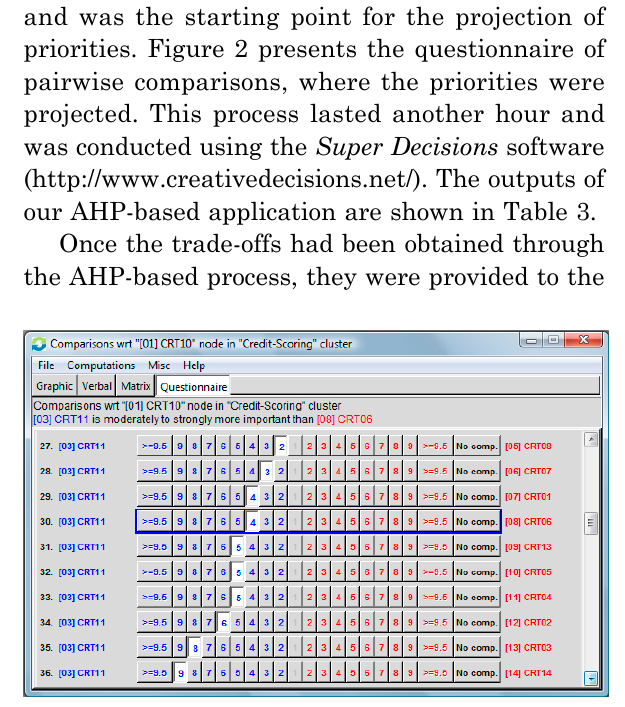
Fig. 2. Pairwise comparisons [Super Decisions software] (Ferreira et al. 2014a) Table 3. Criteria ranking and “AHP” trade-offs Criteria